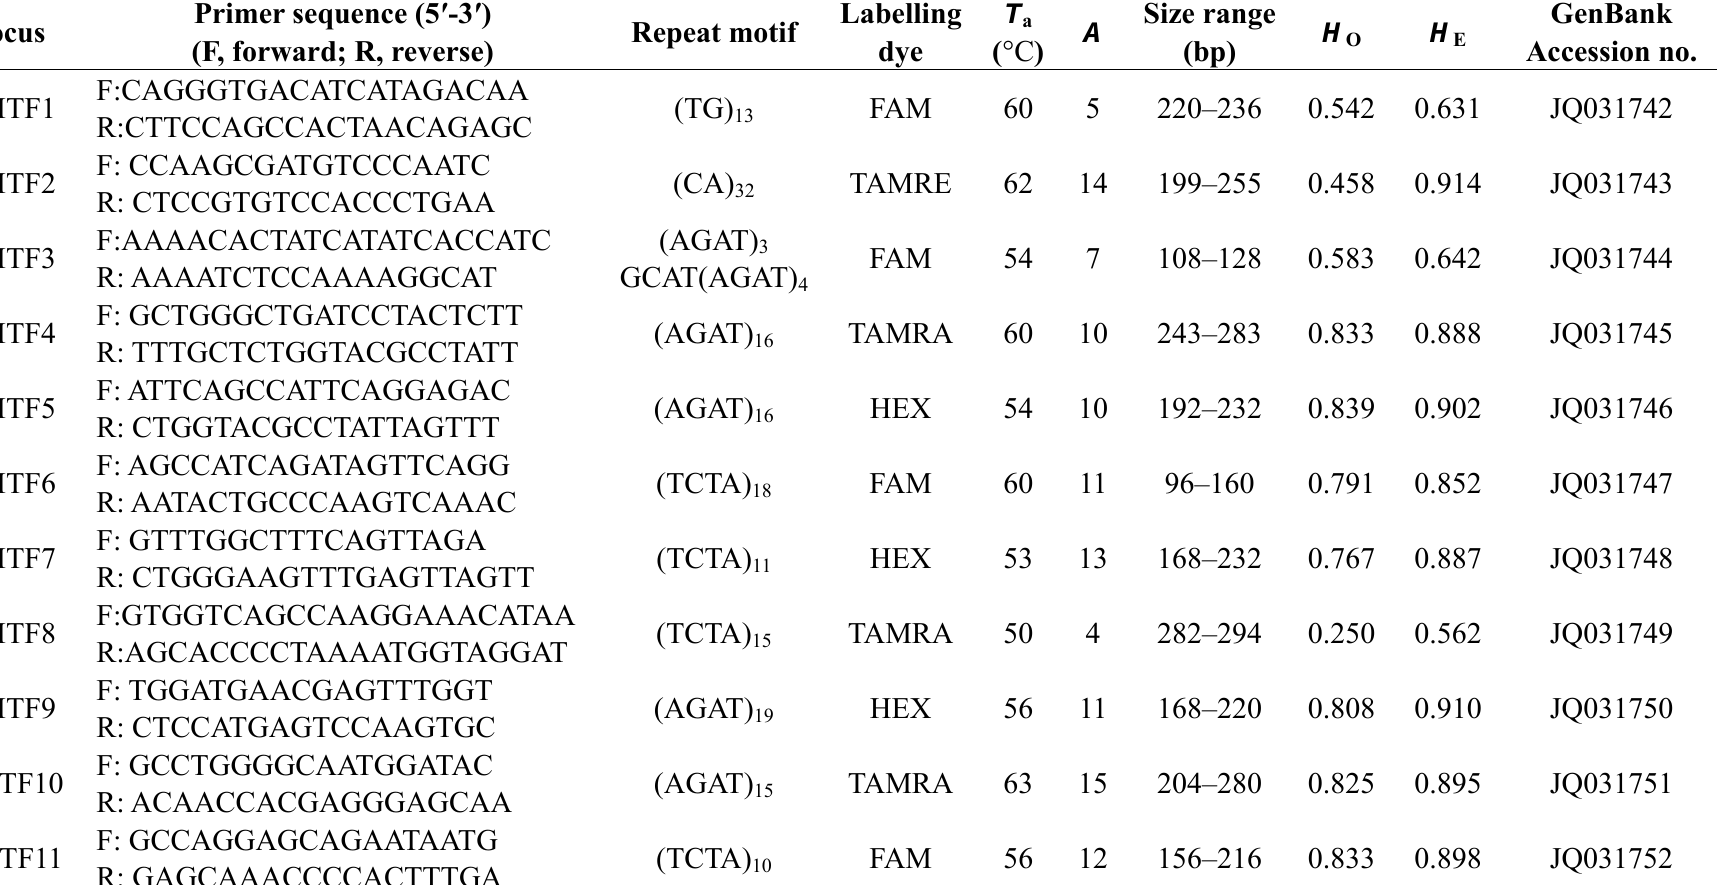
Table 1. Characteristics of eleven polymorphic microsatellite loci in the Omei treefrog ( Rhacophorus omeimontis ). T A , number of alleles; H , observed heterozygosity; H O